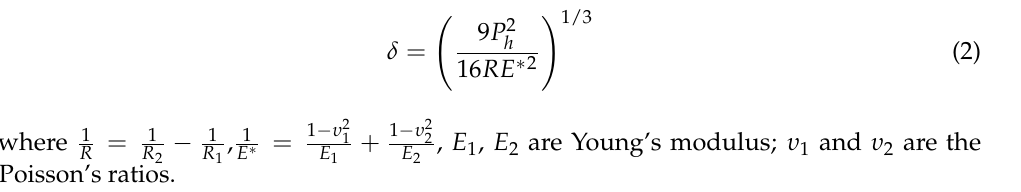
2 2 = 1 − 1 = 1 − υ + 1 − υ 1 2 , 1 , E 1 , E 2 are Young’s modulus; υ 1 and υ 2 are the R R 2 R 1 E ∗ E 1 E 2